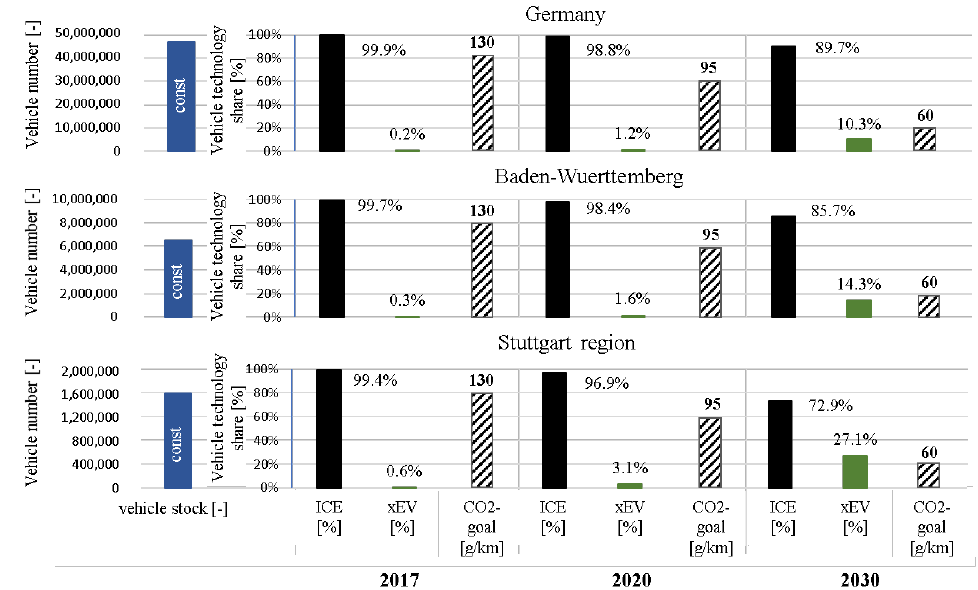
Figure 2. Forecast scenarios for the vehicle fleet electrification in Germany. According to the National Platform for Electric Mobility (NPE), 77,100 charging points have to be set up for one million xEVs, corresponding to around 13 xEV per charging point [23]. Extrapolating this recommendation into 2030, around 37,000 public charging points should be built by 2030 in Greater Stuttgart. The costs for procurement and in- stallation of these charging points were determined according to NPE roadmap charging infrastructure. This roadmap provides a forecast of the charging infrastructure costs in the categories “Smart charging box”, “AC charging station” and “DC charging station” for 2020, as shown in Table